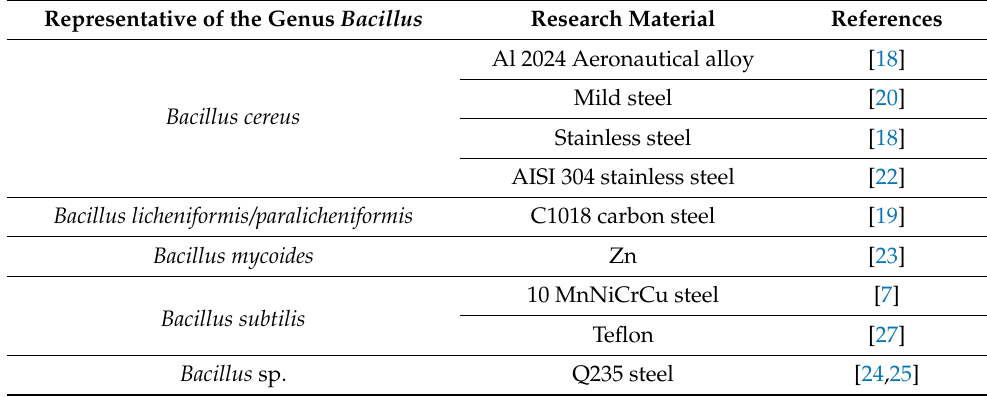
Table 2. Diversity of members of the genus Bacillus involved in biodamage of metals and